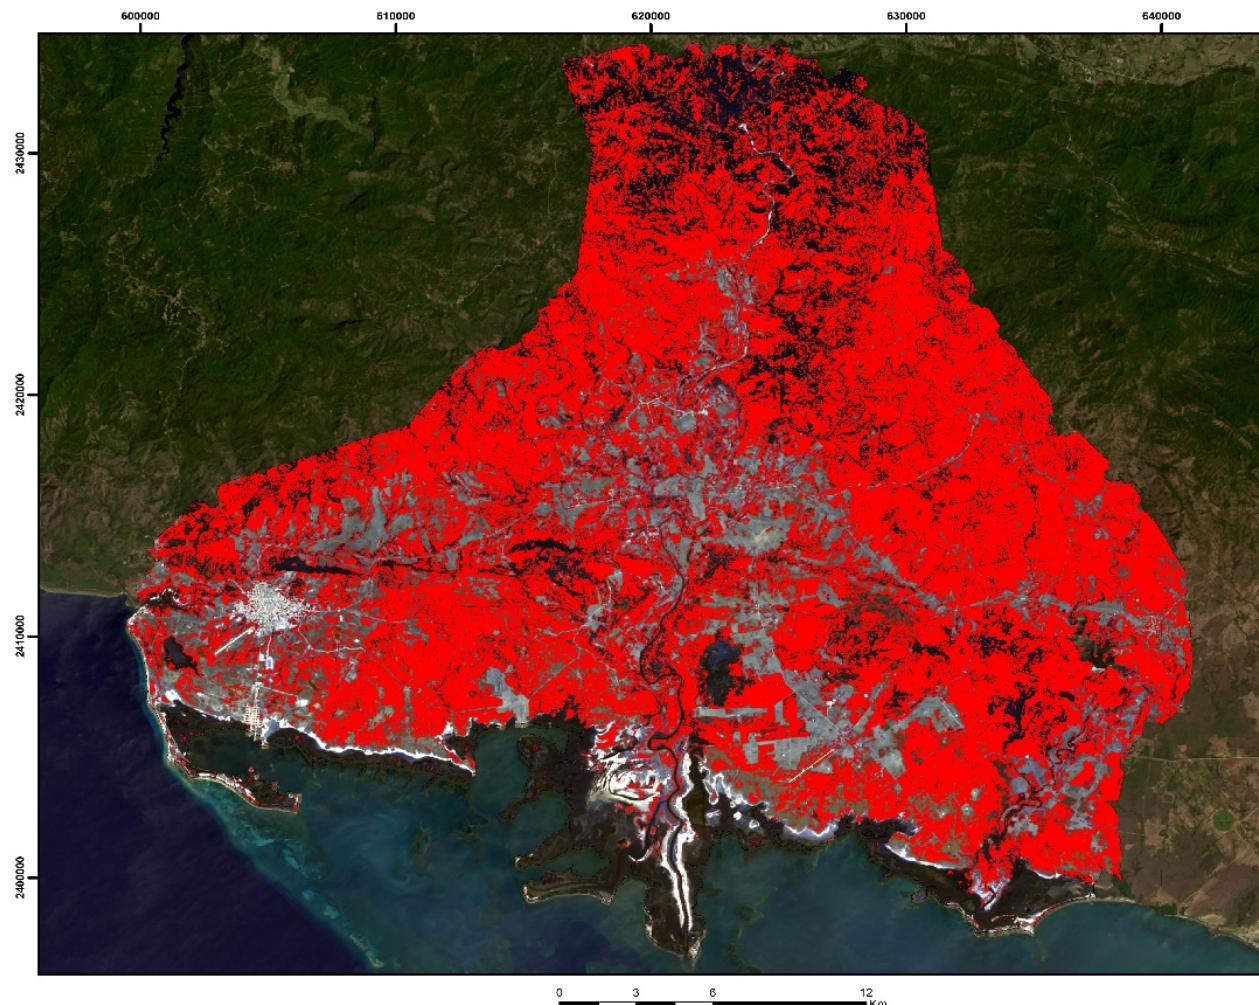
Figure 6. Spatial distribution of sicklebush (shown in red) based on analysis of Landsat-8 image of Trinidad-Valle de los Ingenios, Cuba. Datum: WGS1984; Spatial reference: UTM zone 17N; Latitude of origin: 0; Scale factor: 0.9996; Central meridian: − 81; False northing: 0; False easting: 500,000.